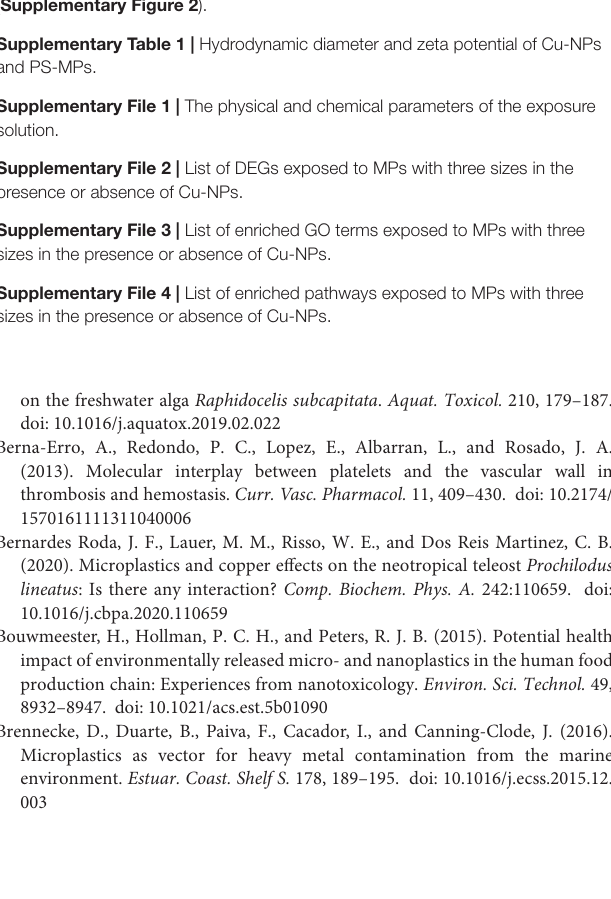
Supplementary Figure 1 | Hierarchical cluster analysis of DEGs among different treatments. Supplementary Figure 2 | Gene ontology (GO) enrichment analysis of DEGs ( Supplementary Figure 2 ). Supplementary Table 1 | Hydrodynamic diameter and zeta potential of Cu-NPs and PS-MPs. Supplementary File 1 | The physical and chemical parameters of the exposure